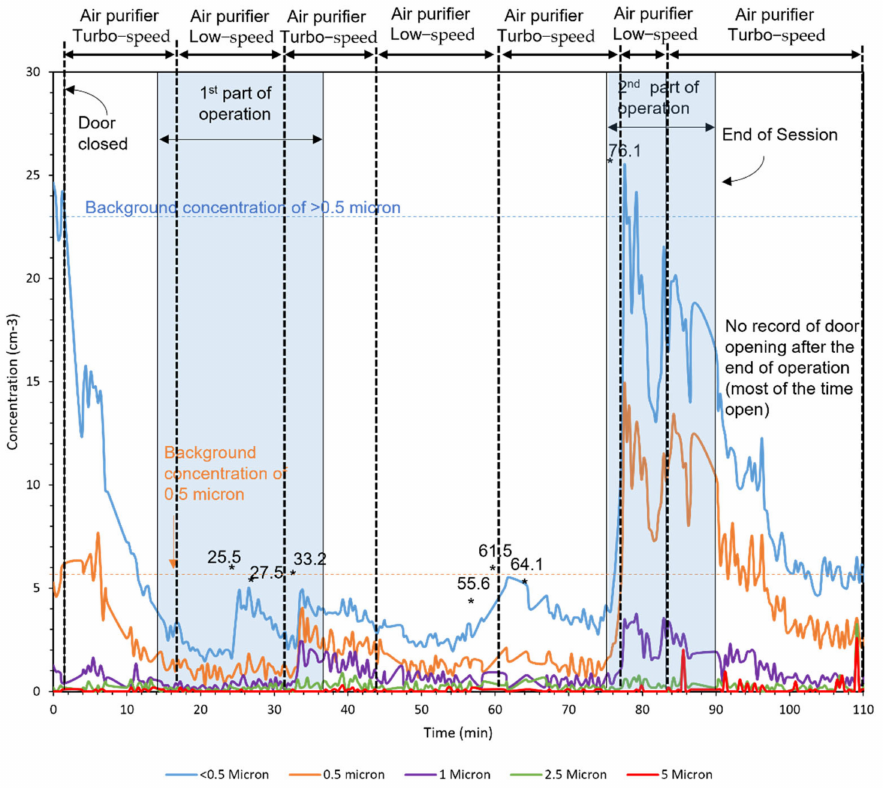
Figure 8. Operation 1 in room A (Large room). Asterisks in the figure represent the moments that the door was open.